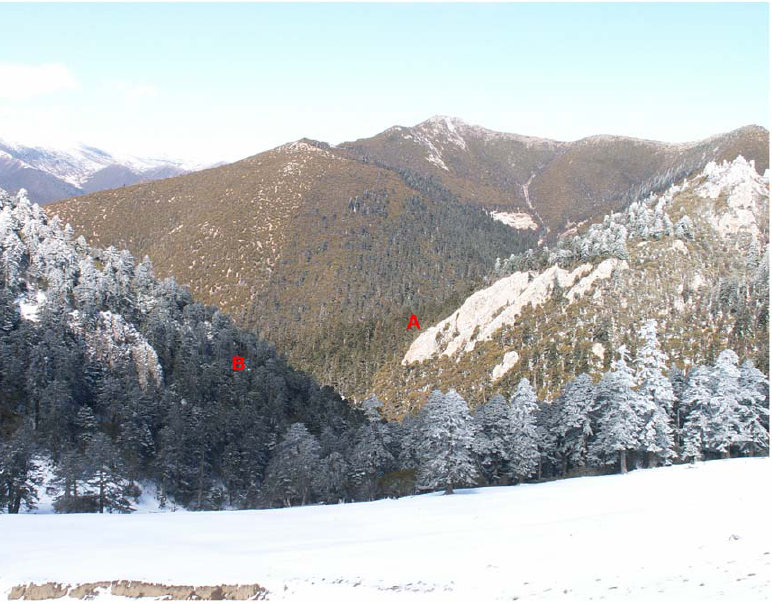
Figure 5. Two neighboring ranges (A and B) with different amounts of solar radiation on the second day after snow. A: there was almost no snow covering the tree canopy in a range with an average solar radiation about 241 KWH/m 2 (MAP 2, see Table 1); this is one of the preferred habitats immediately after snow (see Fig. 3). B: a snow layer of about 5–7 cm covered most of the tree canopy in a range with solar radiation of 180 KWH/m 2 (MAP 5); the canopies were usually not available for foraging for about 3 to 4 days after snow.